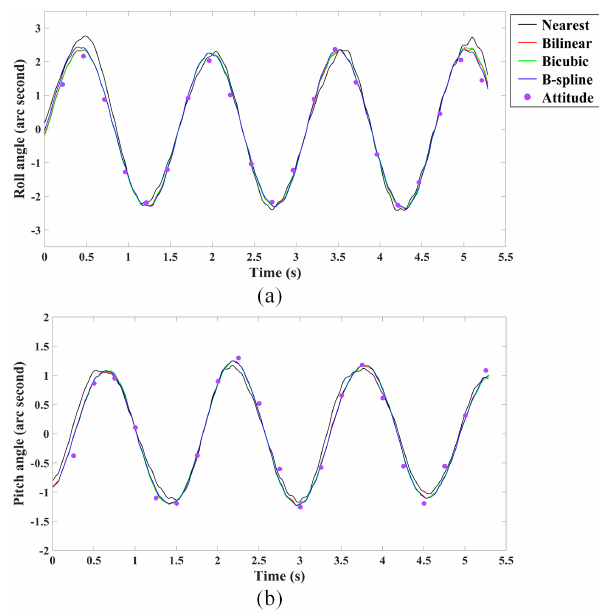
Figure 5. The derived variations of a) roll angle and b) pitch angle using jitter detection method with different interpolators and the reference from attitude measurement data.